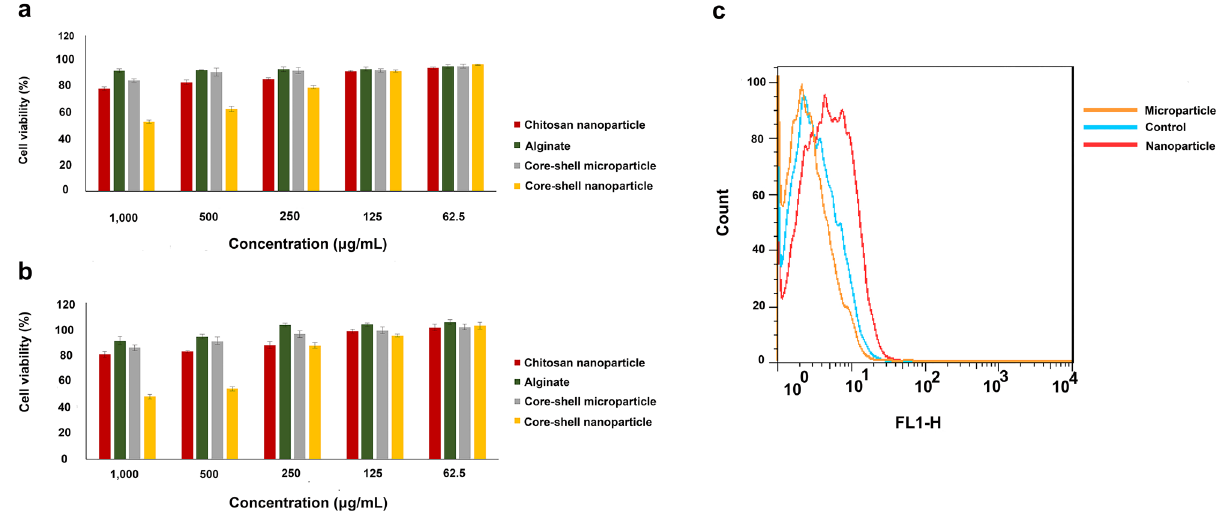
Figure 8. ( a ) Cell viability of micro/nanoparticles at 24 h; ( b ) cell viability of micro/nanoparticles at 72 h and ( c ) cellular uptake of Nile-red from fluorescence-labeled core–shell micro/nanoparticle by flow